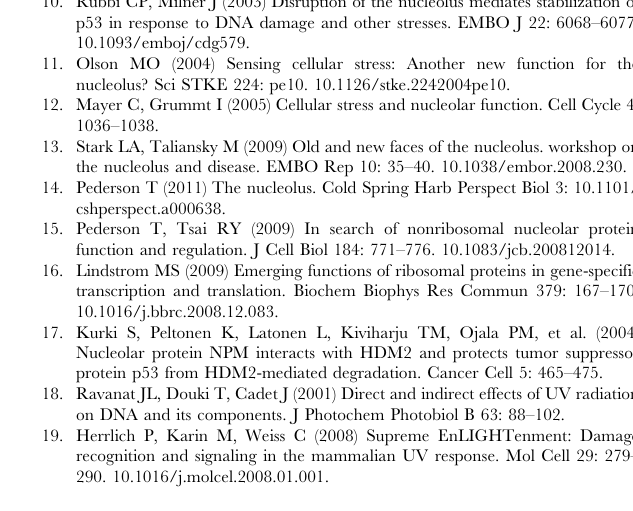
Figure S4 NPM half-life is unaltered following UV damage. A and B , U2OS cells were treated with UV (35 J/m 2 ) and incubated in the presence or absence of cycloheximide (CHX, 50 m g/ml) for the indicated times. Cell lysates were prepared and analyzed by immunoblotting for NPM and GAPDH as control. C , U2OS cells were treated with UV (35 J/m 2 ) in the presence or absence of cycloheximide (50 m g/ml) and incubated for 3 h. Fixed cells were stained for NPM ( red ) and DNA ( blue ). D , U2OS cells were treated with UV (35 J/m 2 ) in the presence or absence of a - amanitin (25 m g/ml) and incubated for 3 h. Fixed cells were stained for NPM ( red ) and DNA ( blue ). (TIF) Figure S5 Nutlin-3 does not affect NPM redistribution after UV. U2OS cells were treated with either Nutlin-3 (10 m M) or UV (35 J/m 2 ), or pretreated with Nutlin-3 for 1 hour followed by UV treatment and incubated for 3 hours, or left untreated (control). The cells were fixed and stained for NPM and p53. Scale bar, 20 m m. (TIF) Figure S6 UbE1 inhibitor induces p53 response. WS1 cells were treated with UV (35 J/m 2 ) or UbE1 inhibitor (10 m M) and incubated for 19 hours or left untreated. The cells were fixed and stained for p53. (TIF) Figure S7 Silencing of 20S proteasome. HeLa cells were transfected with specific siRNAs against 20S a proteasome and the cells were incubated for 72 hours. Equal amounts of total protein were separated by SDS-PAGE and immunoblotted for p53 and 20S. Tubulin was used as a loading control.